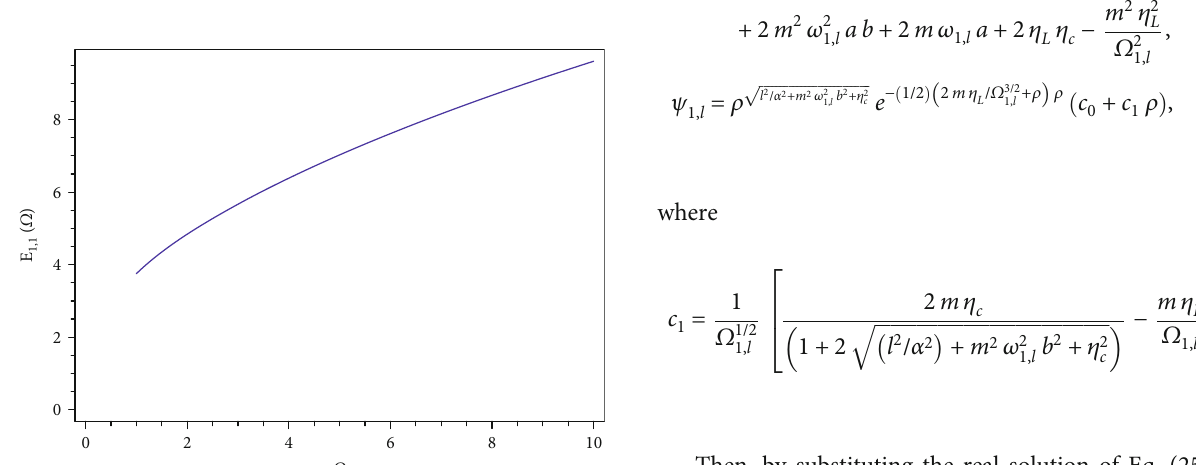
= η = M = 1 , α = 0 : 5 c L